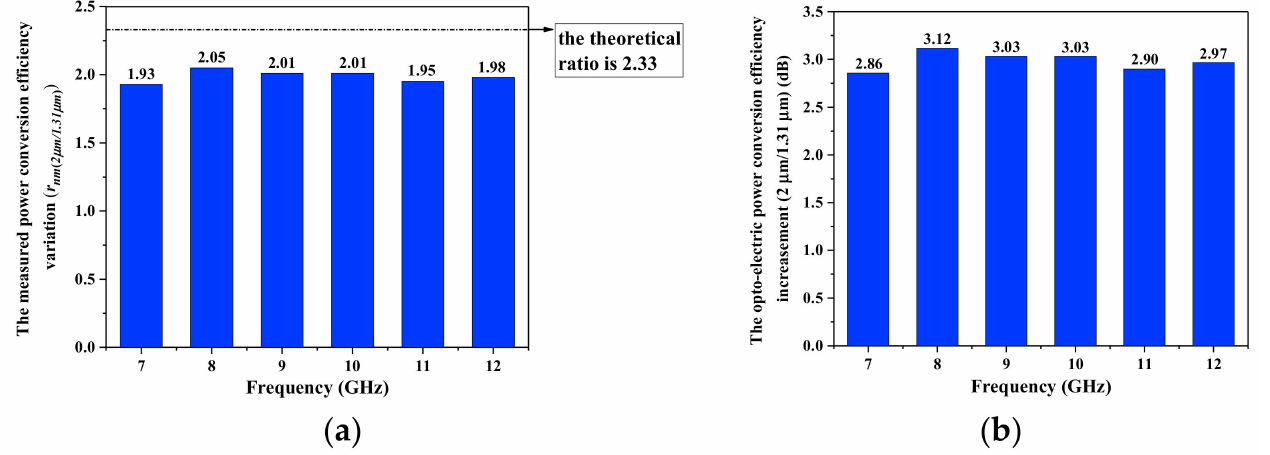
Figure 6. ( a ) The theoretical/measured power conversion efficiency variation r nm ( 2 µ m/1.31 µ m ) = 2 2 ( P ) / ( P ) ; ( b ) the opto-electric power conversion efficiency increasement E 2 µ m / η E 1.31 µ m / η 2 µ m 1.31 µ m (2 µ m/1.31 µ